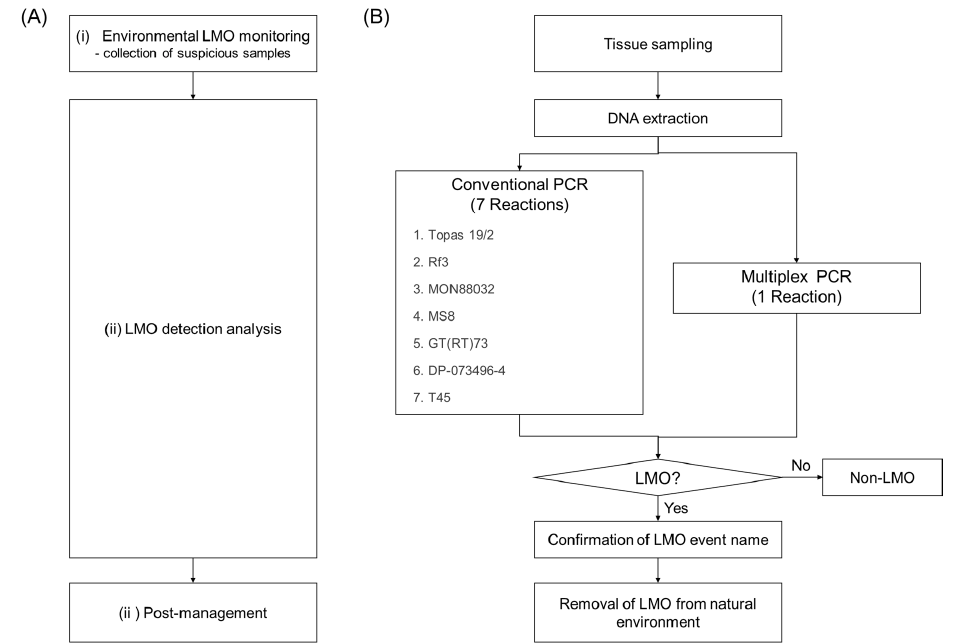
Figure 1. Processing scheme for the environmental living modified organism (LMO) monitoring and post-management project. ( A ) Three steps for the LMO monitoring. ( B ) Flowchart to show the efficiency of the multiplex PCR for the LMO detection analysis.